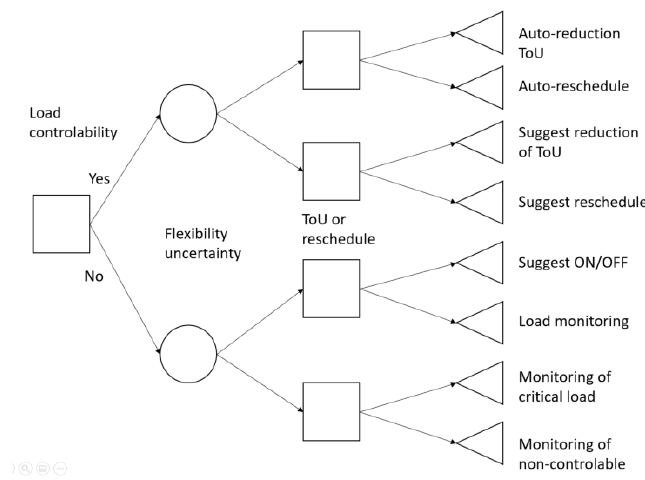
Figure 7. Decision tree for load management.